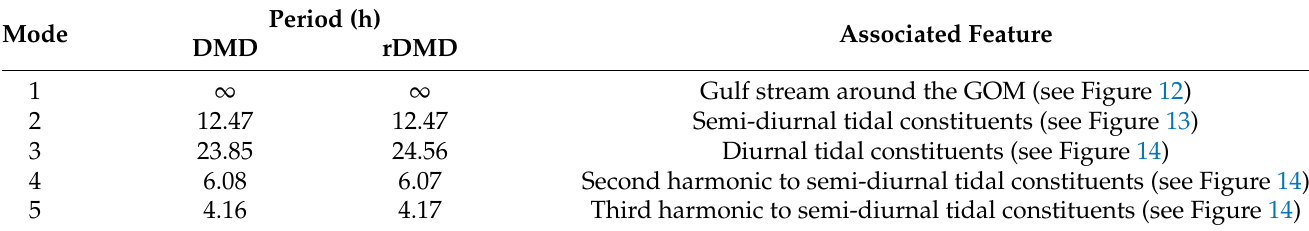
Table 3. DMD modes for the Gulf of Mexico data set. Modes are selected based on the association to the tidal periods.